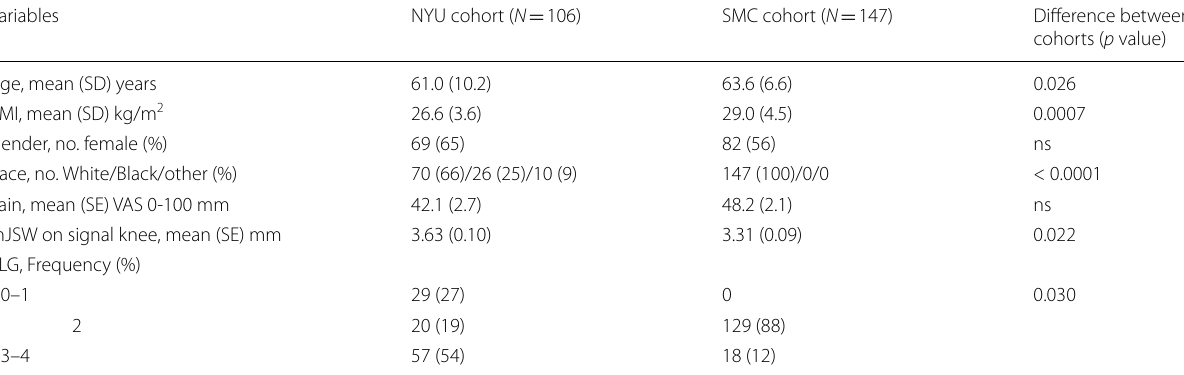
Table 2 Correlation (multiple linear regression) between PRO‑C2 and baseline characteristics